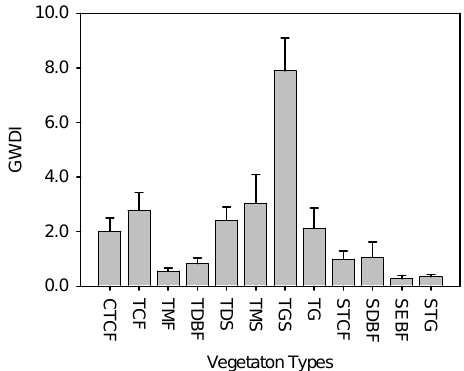
Fig. 5. Growing season water deficit index (GWDI) of different veg- etation types. Data are spatial means for the period